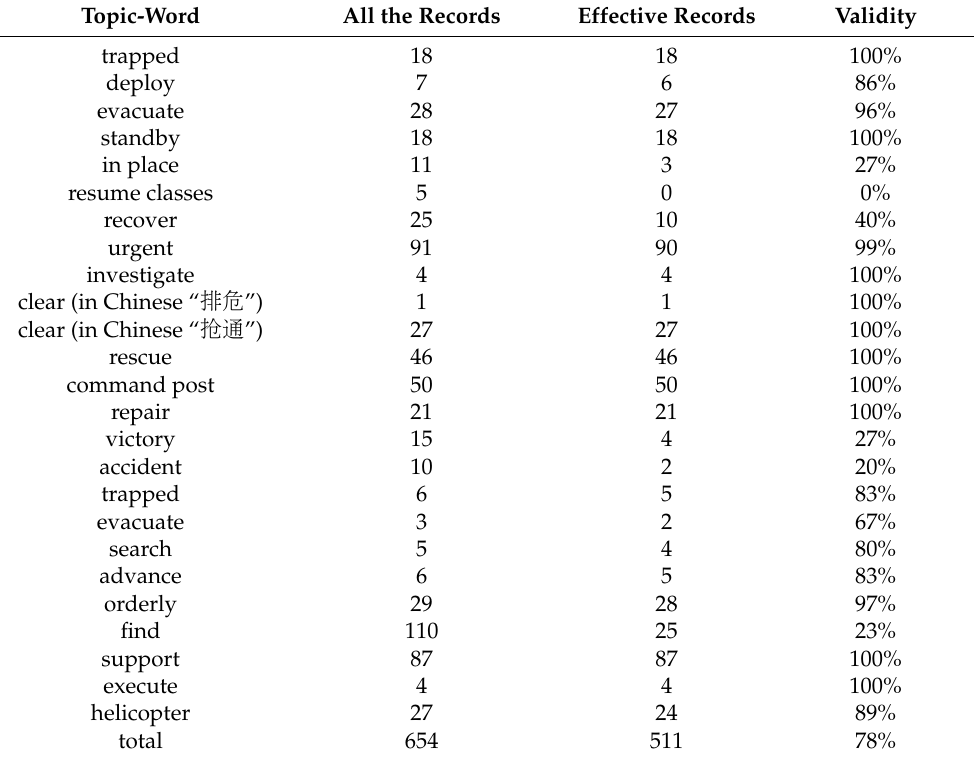
Table 9. Results of the single topic-word validity